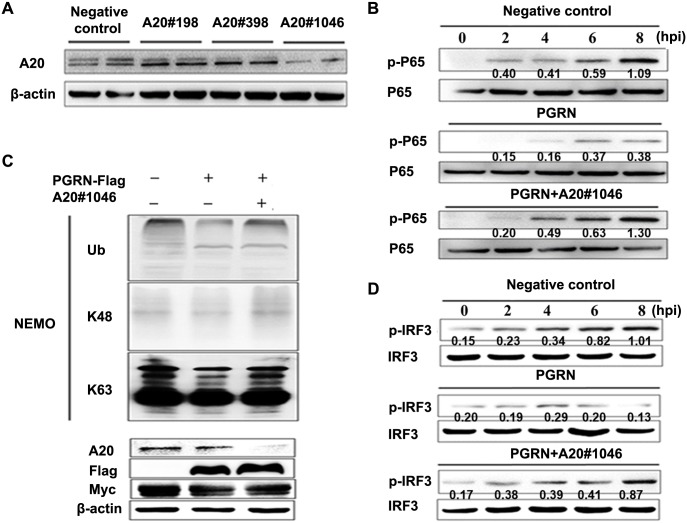
The regulatory effect of PGRN is dependent on A20.(A) Serum-starved HEK293 cells were transfected with negative control or A20-targeting siRNAs (#198, #398 and #1046) to silence A20, and 48 h later, the expression of A20 was measured by western blot. (B) HEK293 cells were co-transfected with a plasmid encoding FLAG-tagged PGRN and either negative control or A20-targeting siRNA #1046, and infected with PR8 virus at an MOI of 1. After 8 hpi, immunoblotting was used to assess K63-linked polyubiquitination of NEMO. (C) HEK293 cells were co-transfected with vectors encoding FLAG-tagged PGRN and either negative control or A20-targeting siRNA #1046, then infected with PR8 virus at an MOI of 1 at the indicated time points. Levels of phosphorylated p65 were measured by western blot. (D) HEK293 cells were co-transfected with vectors encoding FLAG-tagged PGRN and either negative control or A20-targeting siRNA #1046, and infected with PR8 virus at MOI of 1 at the indicated time points. Levels of phosphorylated IRF3 were measured by western blot. All data are representative of three independent experiments showing similar results.